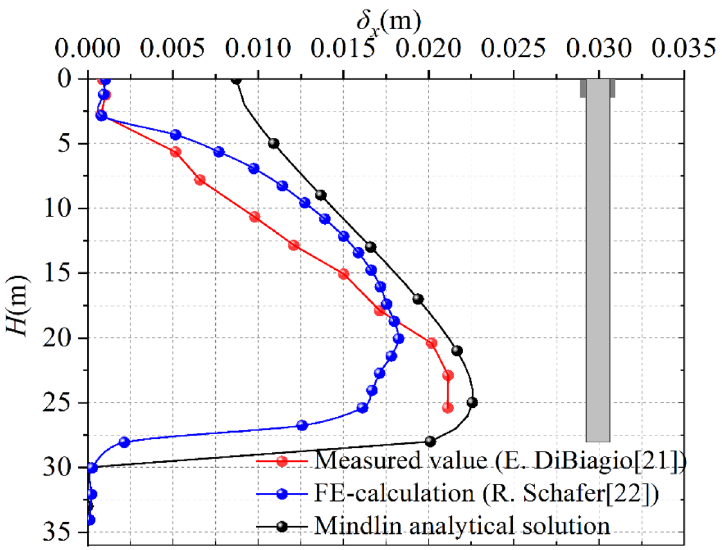
Figure 3. Horizontal displacement comparison results (along the vertical centerline).